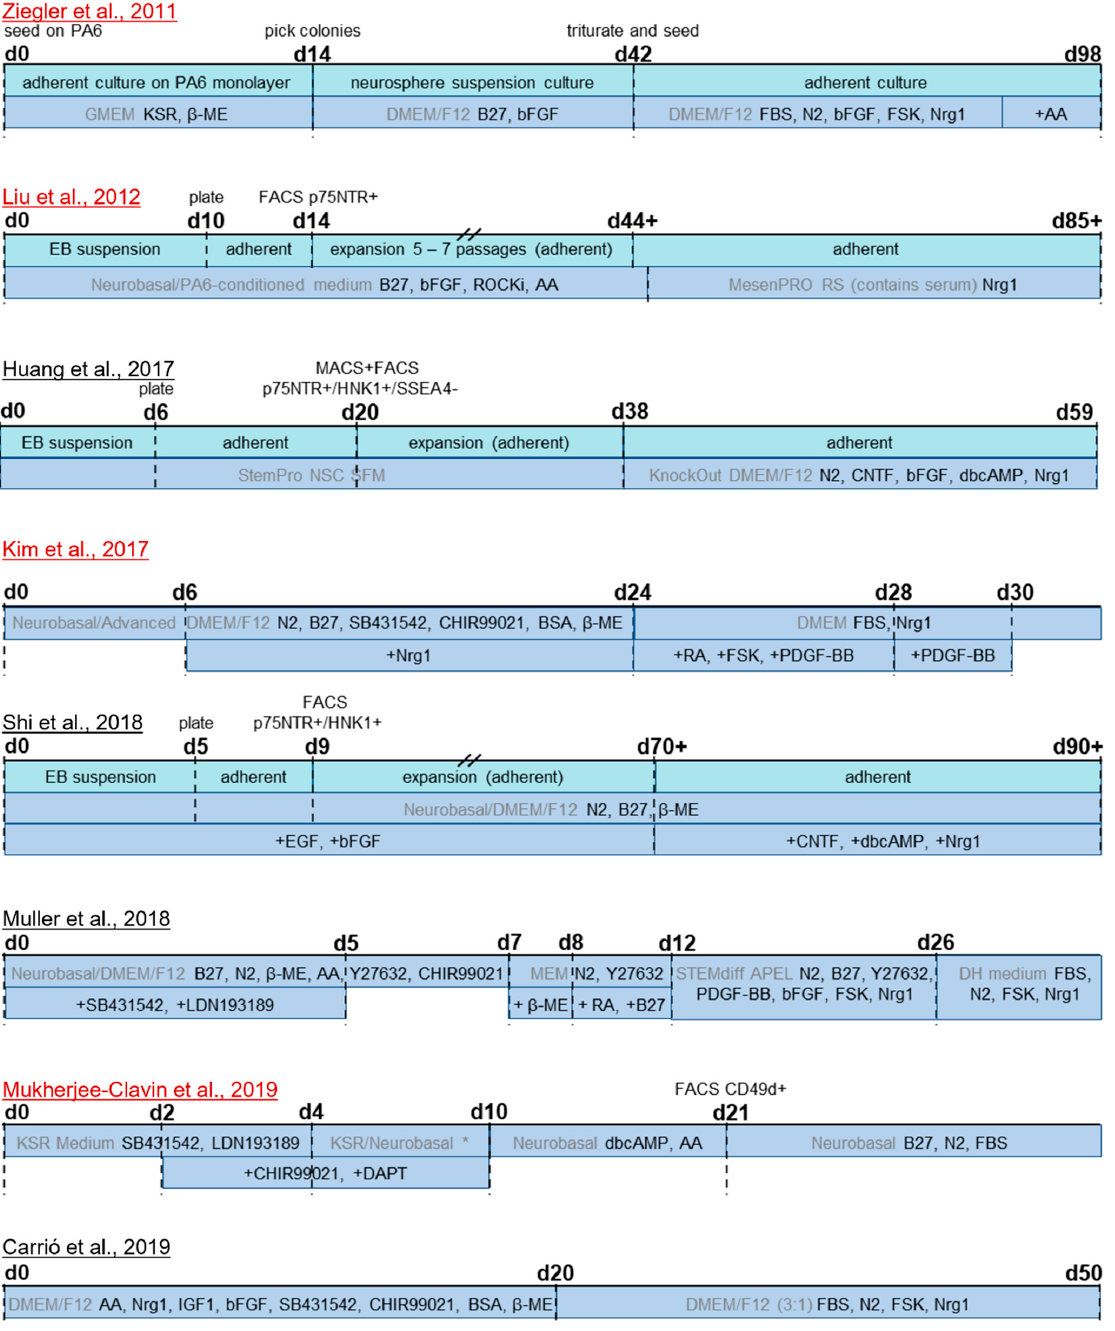
Figure 3. Comparison of hiPSC/hESC based differentiation protocols . Timelines and molecules used are shown for several principal protocols [111,112,116,117,119–121,131]. Publications marked